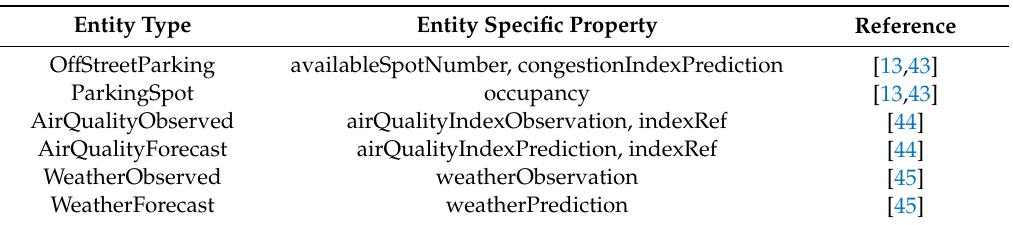
Table 4. A list of data models for parking service.